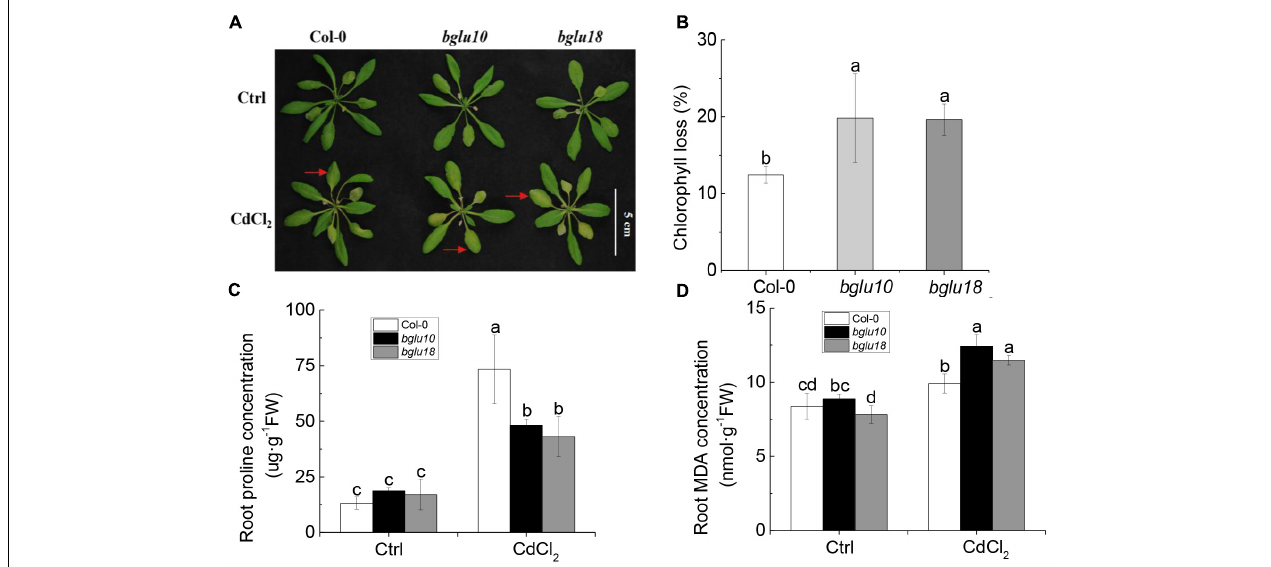
FIGURE 1 | Arabidopsis abscisic acid (ABA) mutants ( bglu10 and bglu18 ) are more sensitive than wild-type (Col-0) under 20 µ M cadmium stress. (A) Photograph showing the higher tolerance of the wild-type (Col.0) as compared with ABA mutants ( bglu10 and bglu18 ). (B) Chlorophyll loss in Cd 2 + treated plants relative to control. (C) Effects of Cd 2 + stress on proline in Col-0, bglu10, and bglu18 plants. (D) Effects of Cd 2 + stress on malondialdehyde (MDA) in Col-0, bglu10, and bglu18 plants. Data represent means ± SE ( n = 4). Bars with the same letter indicate no significant difference at P < 0.05 level by the method of